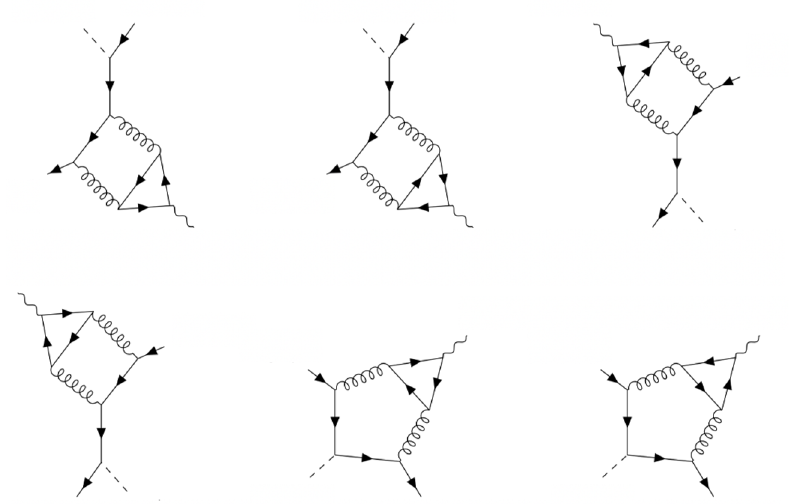
Figure 3 . The two-loop diagrams proportional to (cid:21) b that involve quark triangles. We denote the (cid:12)rst four diagrams by box-triangles and the last two by